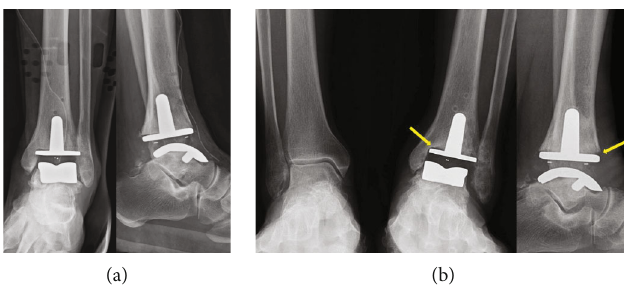
Figure 2: (a) The patient underwent total ankle arthroplasty (TAA). (b) Three months after TAA. The radiological assessment revealed a radiolucent line and osteolysis (yellow arrow) of the tibial component (standing